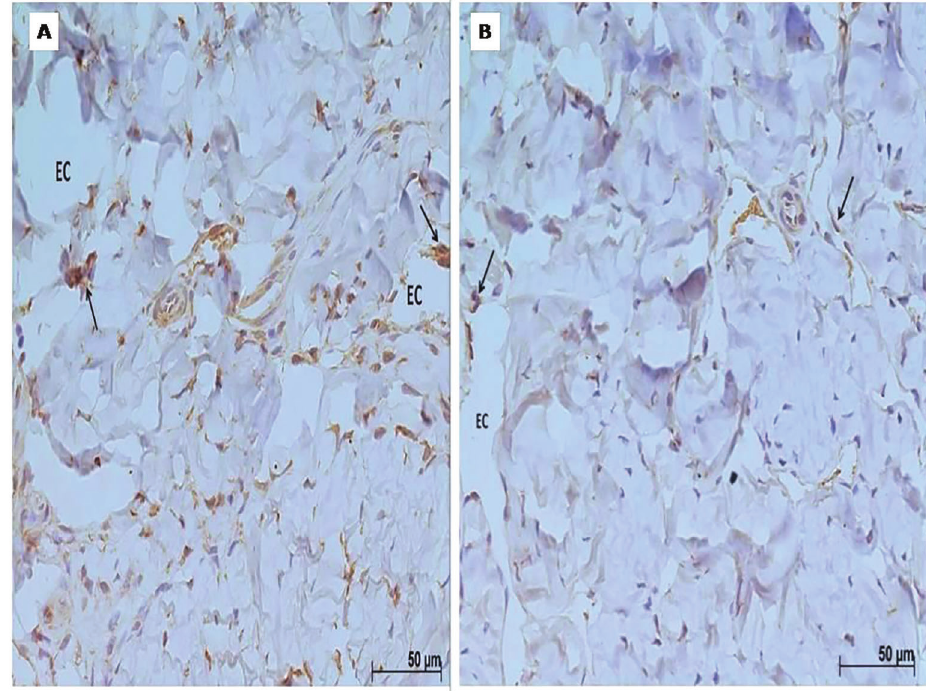
Figure 1. Representative immunohistochemical photomicrography of the overall expression of endothelin B ( Panel A ) and A ( Panel B ) protein in cross-section of the rat cavernous bodies of the alcoholic-diabetic group. Cavernous spaces (EC) and positive markings (arrows) are indicated. Magni fi cation: 400 (cid:1) . The expression of endothelin B and A receptors in corpus cavernosum muscle can be observed in brown.